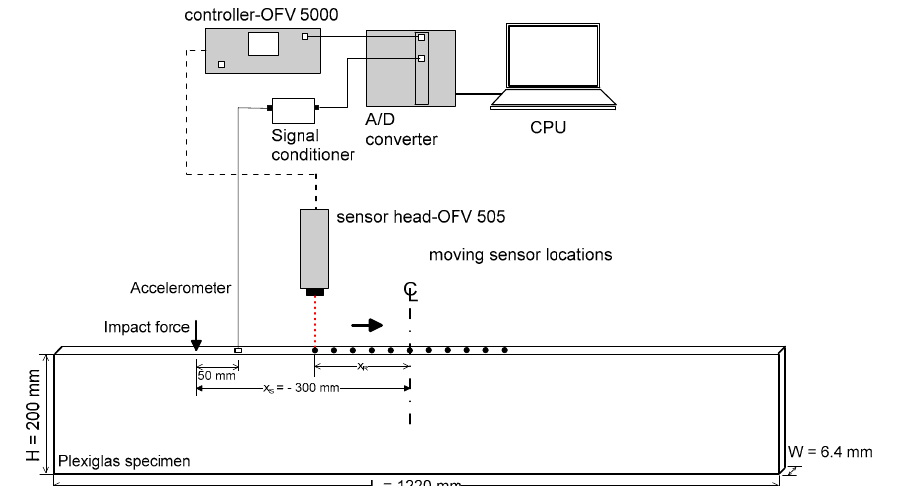
Figure A1. Test setup of laser vibrometer for impact-induced surface wave measurements in a Plexiglas specimen in the laboratory.